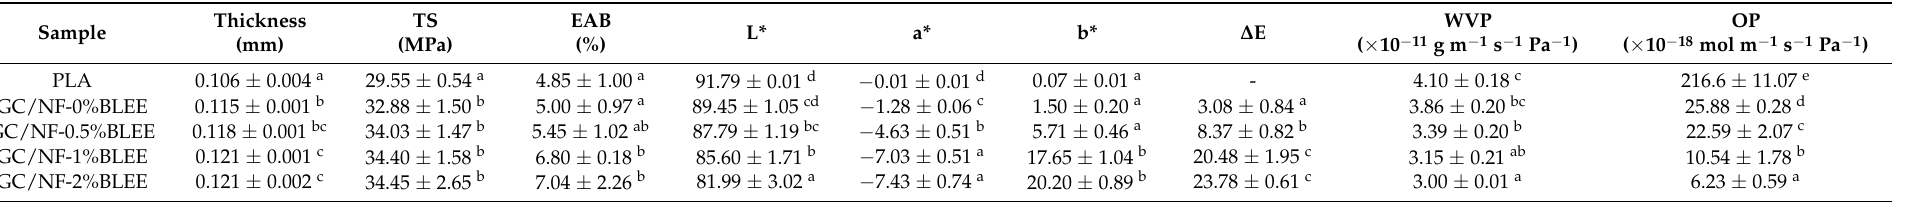
Table 1. Thickness, mechanical properties, color, oxygen permeability, and water vapor permeability of PLA film and PLA films coated with GC/NF loaded with, or without betel leaf ethanolic extract (BLEE) at different